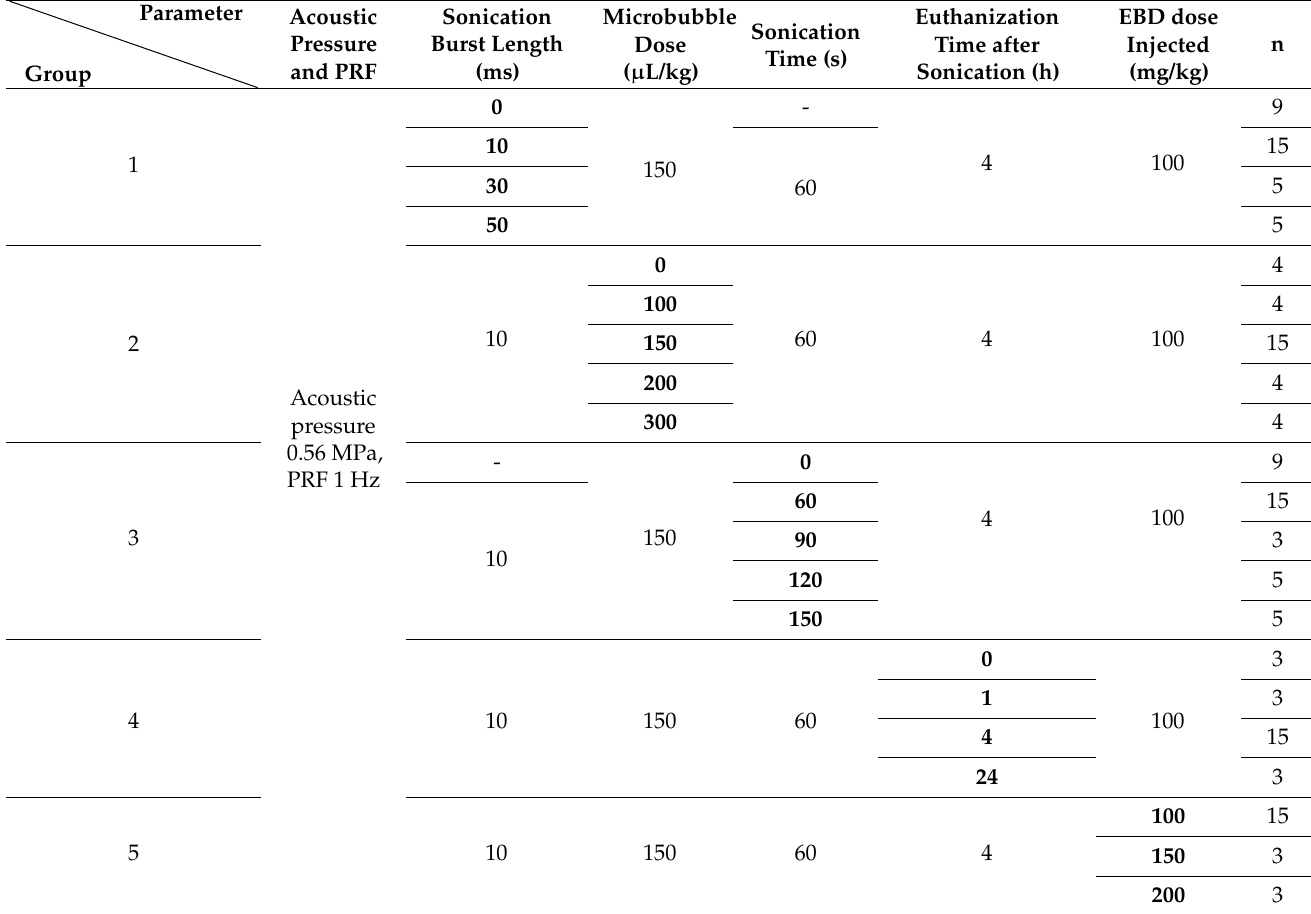
Table 1. Experimental conditions of the parameter study. An acoustic pressure of 0.56 MPa and PRF of 1 Hz were used in all experimental